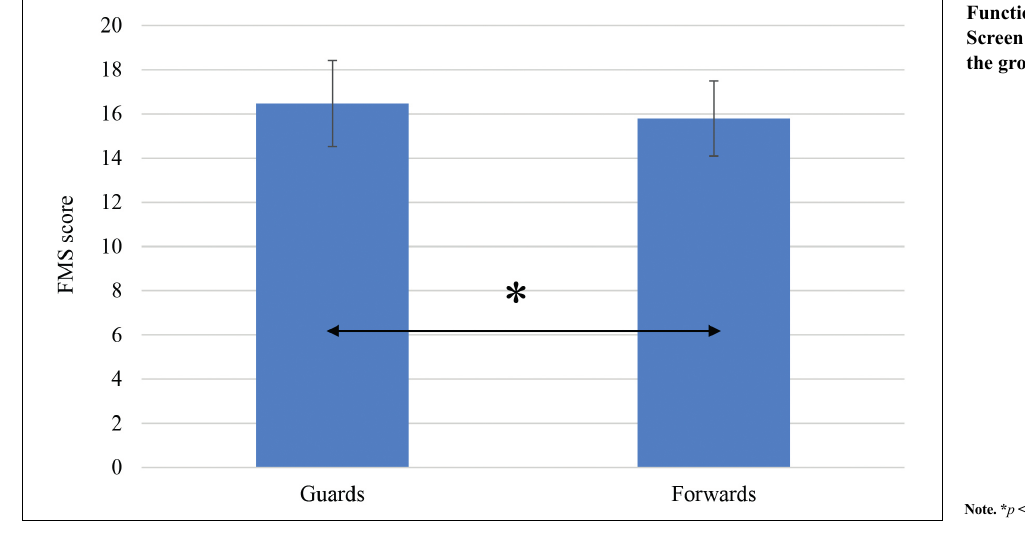
Figure 4. Left and right legs’ composite scores of Y Balance Test™ of the